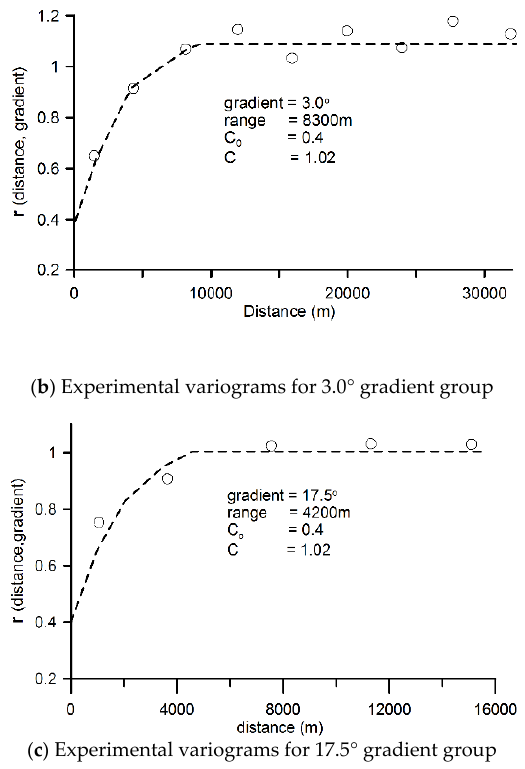
Figure 3. Experimental distance/gradient-based variograms for three gradient groups. The initial distance-variation scatter diagrams were fitted with artificial curves. Then, the mean square deviation C , the nugget effect C 0 , and the corresponding range were estimated according to the interpolated variogram curves.